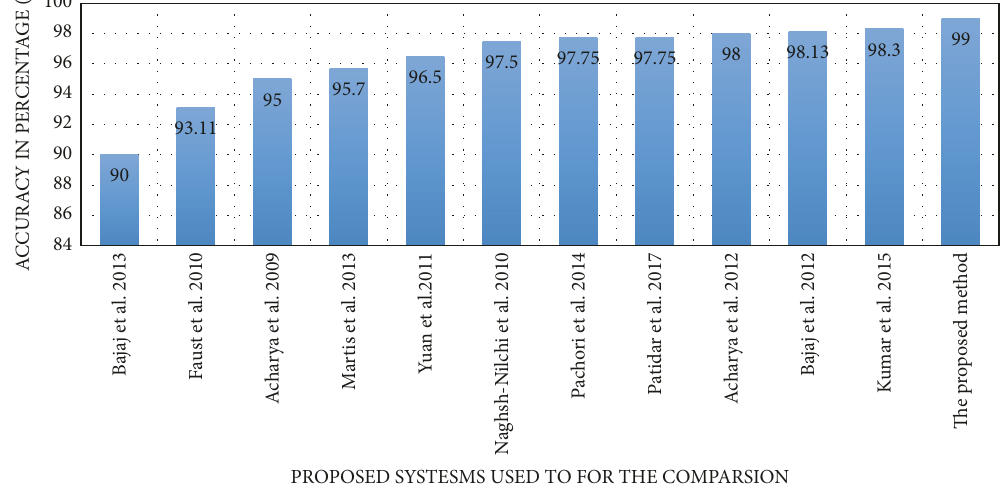
Figure 8: The total accuracy (%) of various methods employed to detect the disorder of the